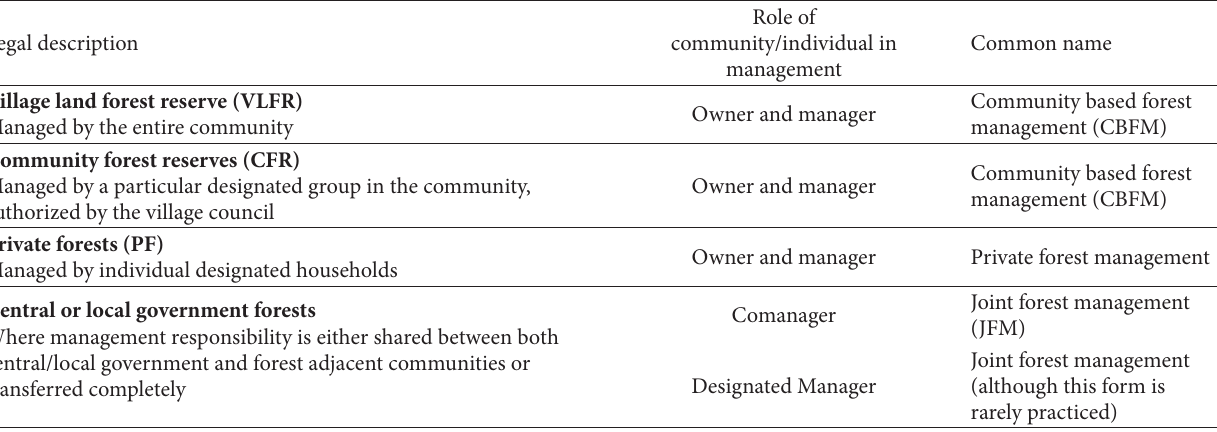
Table 2: Different forest management practice and arrangement in Tanzania.